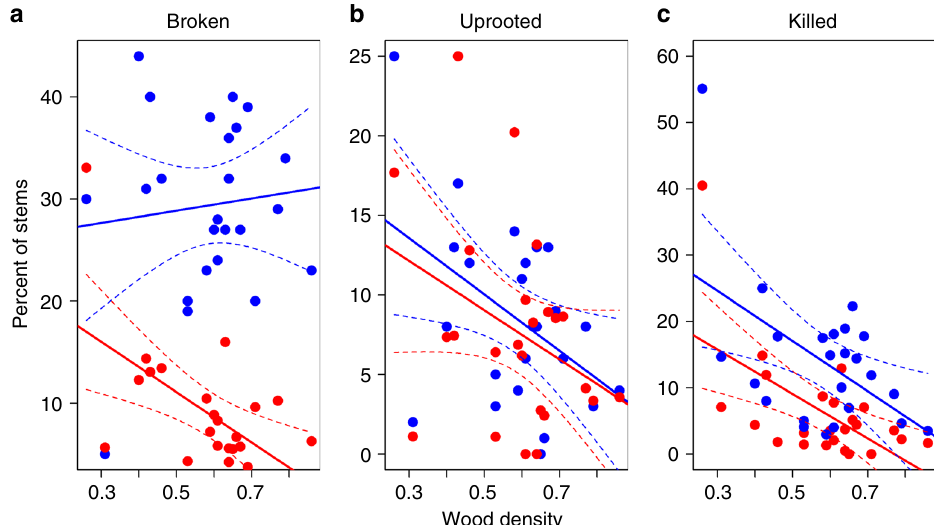
Fig. 4 Relationship between wood density and rates of stem break ( a ), uprooting ( b ), and immediate mortality ( c ) for 24 tree species during Hurricanes Hugo (red dots) and María (blue dots). Dashed lines indicate 95% con fi dence intervals